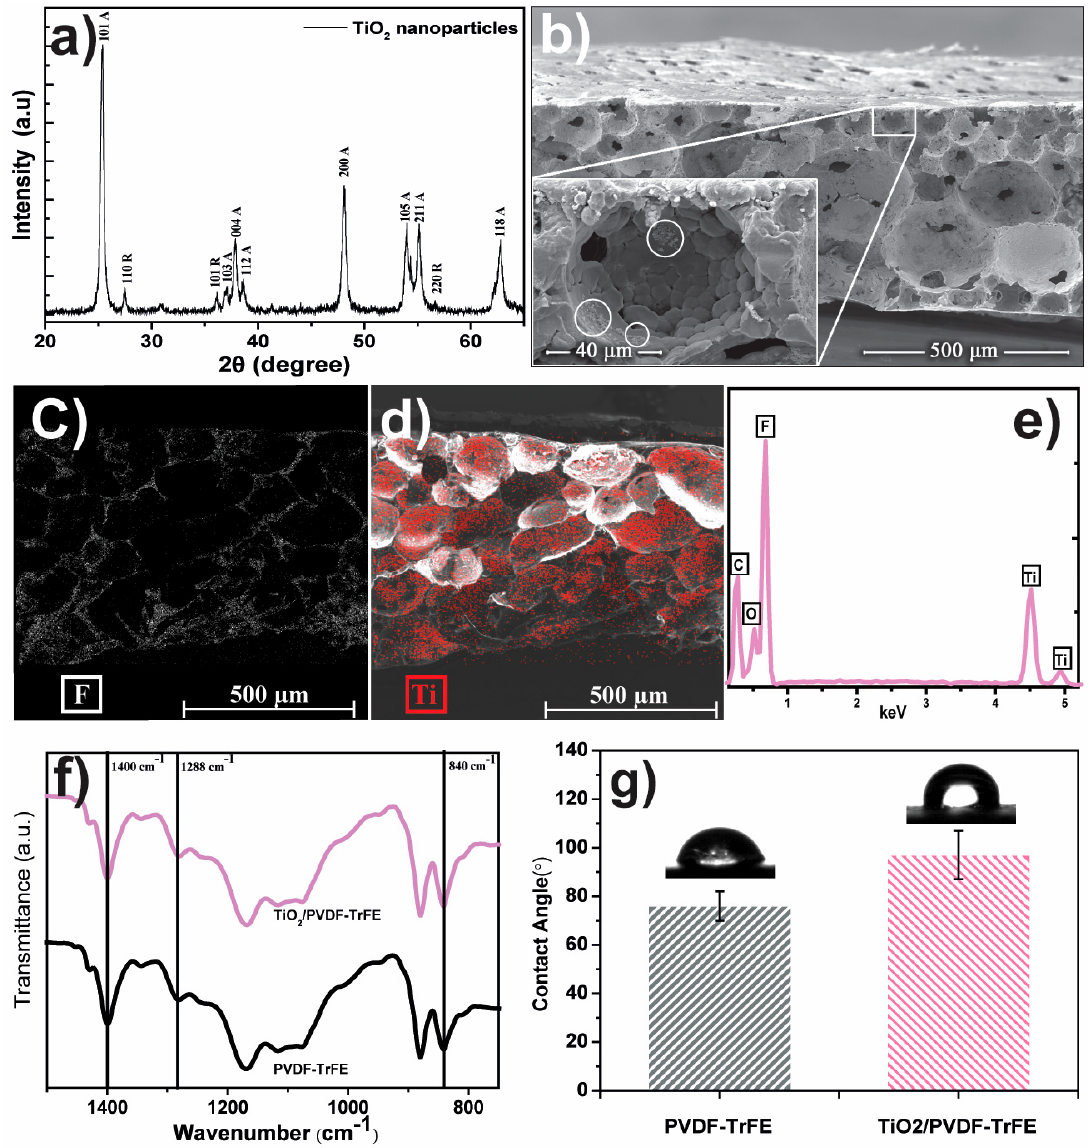
Figure 2. ( a ) XRD pattern of TiO 2 nanoparticles and identification of the di ff erent crystal phases: Anatase (A), and rutile (R). ( b ) Cross-section SEM images of 8 wt.% TiO 2 / poly(vinylidene fluoride–trifluoro ethylene) (PVDF–TrFE) membranes with an inset showing a detail of an interconnected pores, with white circles for TiO 2 nanoparticles and aggregates. SEM-EDX mapping image of the presence and distribution of F (fluorine) ( c ), and Ti (red) ( d ), in the PVDF-TrFE matrix and the EDX spectrum with the identification of the detected elements ( e ). FTIR spectra and contact angle of 8 wt.% TiO 2 / PVDF–TrFE nanocomposite membranes and pure polymer, ( f , g )